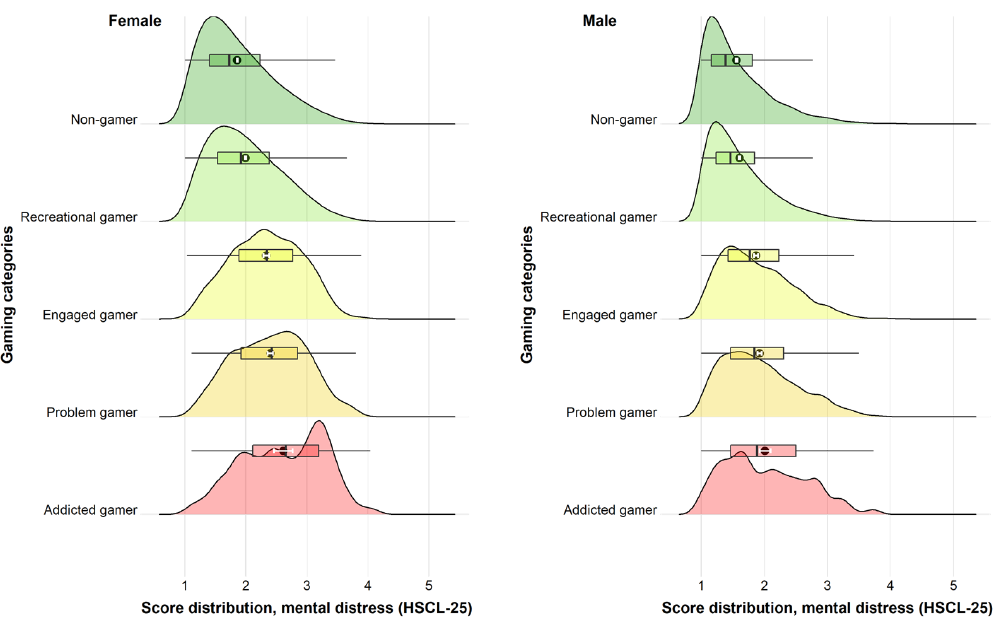
Figure 2. Association between gaming categories and mental distress. Ridgeline plots. Density distributions and corresponding boxplots (with outliers truncated). Black dot indicates mean estimate and white horizontal error bar indicates 95% confidence interval of the mean estimate.